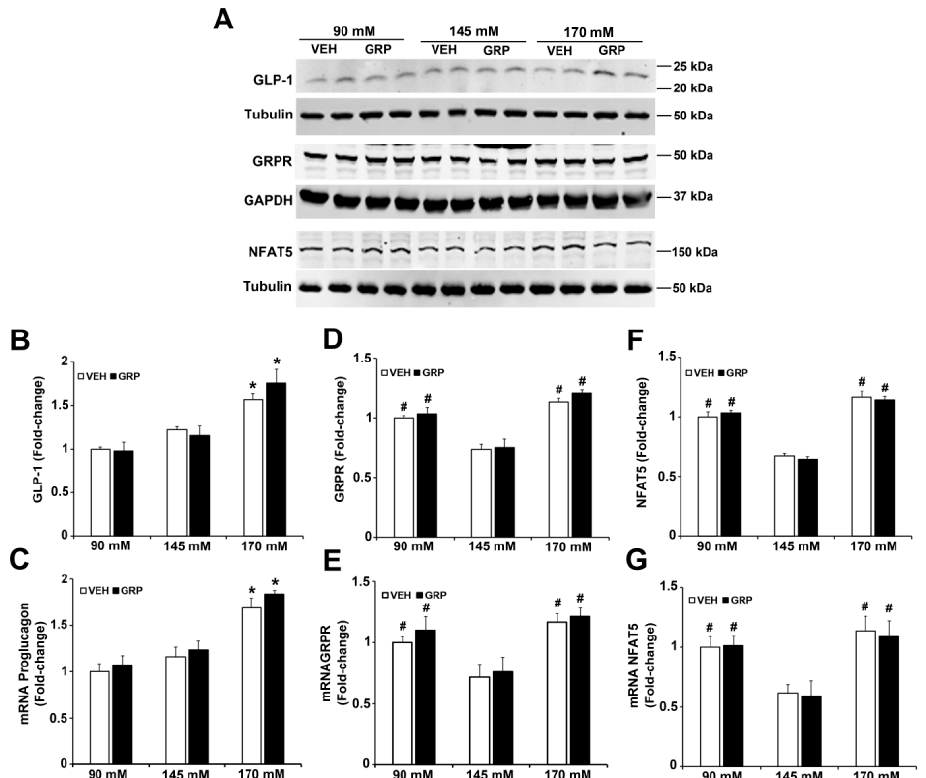
Figure 3. Expressions of GLP-1, GRPR, and NFAT5 in L-cells exposed to varying NaCl concentrations with or without GRP treatment. The same quantities of L-cells were exposed to 90 mM, 145 mM, or 170 mM NaCl, and treated with vehicle (VEH) or GRP (1000 nM) for 4 h. Expressions of GLP-1, GRPR, NFAT5, and proglucagon in L-cells were measured by immunoblotting and RT-qPCR. ( A ), 1 set of blots from 3 independent experiments. ( B , D , F ), quantifications of GLP-1, GRPR, and NFAT5 protein levels in L-cells after 4-h treatment. GAPDH or tubulin protein was used for normalization of the data. * p < 0.05 vs. 90 mM or 145 mM. # p < 0.05 vs. 145 mM. One-way ANOVA, Holm–Sidak test, n = 3/group. ( C , E , G ), quantifications of proglucagon, GRPR, and NFAT mRNA in L-cells after treatment for 4 h. GAPDH or tubulin mRNA was used for normalization of the data. Quantifications were finally expressed as fold-change, relative to the 90 mM group. * p < 0.05 vs. 90 mM or 145 mM. # p < 0.05 vs. 145 mM. One-way ANOVA, Holm–Sidak test, n =